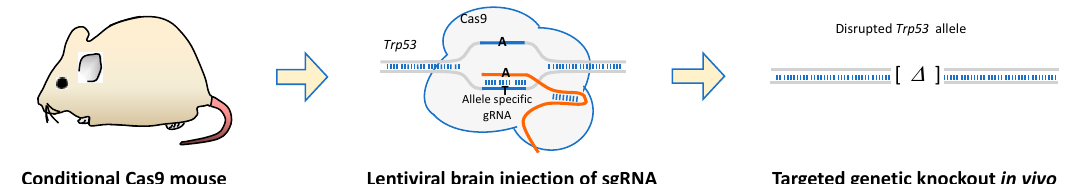
Figure 3. Somatic mutagenesis using clustered regularly interspaced short palindromic repeats (CRISPR)-cas9 for developing glioma genetically-engineered mouse models (GEMMs). A new and efficient method for generating somatic gene knockout is by crossing a conditional-Cas9 transgenic mouse with the appropriate cre for recombination in the cells of interest. Lentiviral delivery of single guide RNAs (sgRNAs) through stereotaxic brain injections will lead to knockout of the gene of interest (eg Trp53 ) only in the cells expressing Cas9 where cre-mediated recombination has occurred.